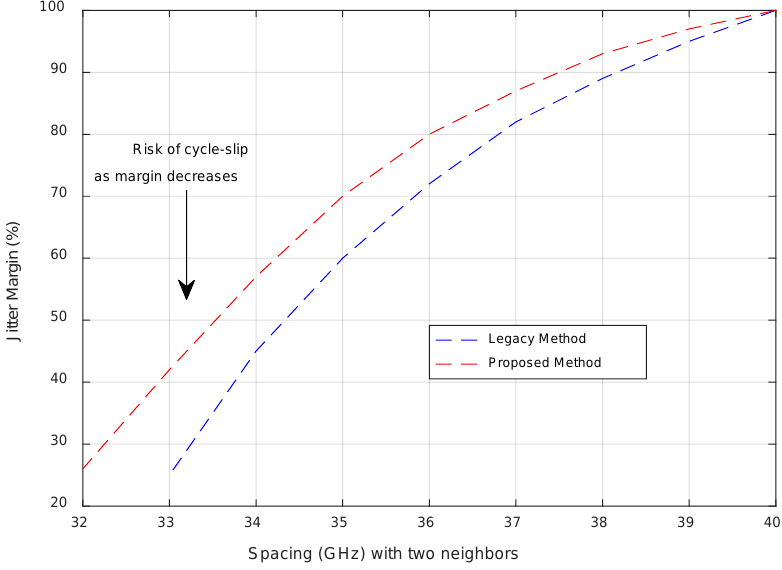
Figure 11 . Optimization of jitter through setting the proper tracking Figure 11. Optimization of jitter through setting the proper